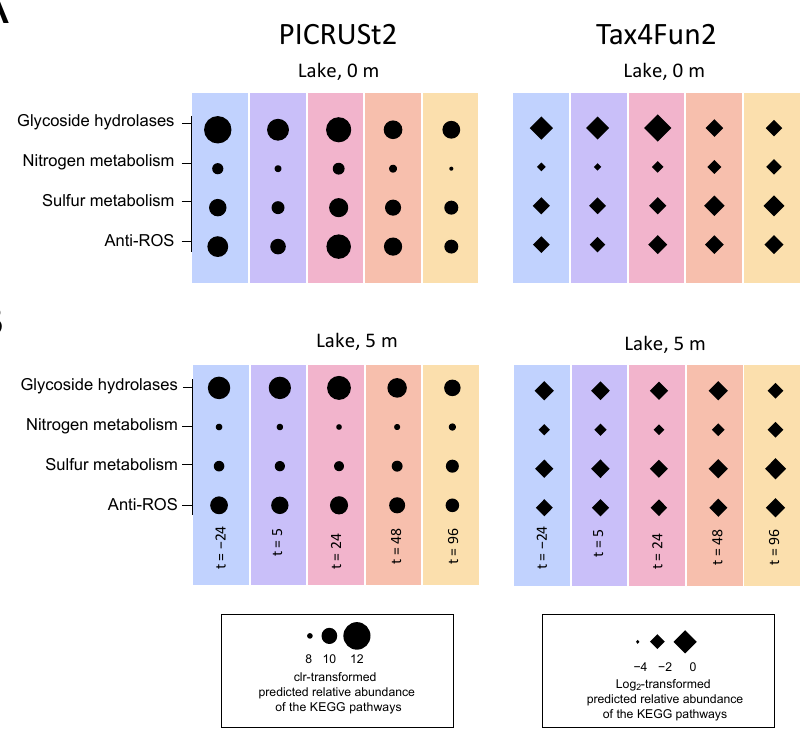
Figure 9. Functional prediction of the microbial community during the lake treatment in August. The graphs show predicted relative abundances of the selected KEGG orthologs or pathways for glycoside hydrolases, nitrogen and sulfur metabolism and anti-ROS enzymes at ( A ) the 0-m depth and ( B ) the 5-m depth during the lake treatment in August. The relative abundances of the selected KEGG orthologs or pathways were predicted by PICRUSt2 (circles) or Tax4Fun2 (triangles). The PICRUSt2 predictions are shown as clr-transformed counts while the Tax4Fun2 predictions are shown as log 2 -transformed percentages. Columns show the average of the predicted relative abundances of n = seven biological replicates for the first time point (t = − 24 h) at the 0-m depth, n = six biological replicates for the first time point at the 5-m depth and n = four biological replicates for all the other time